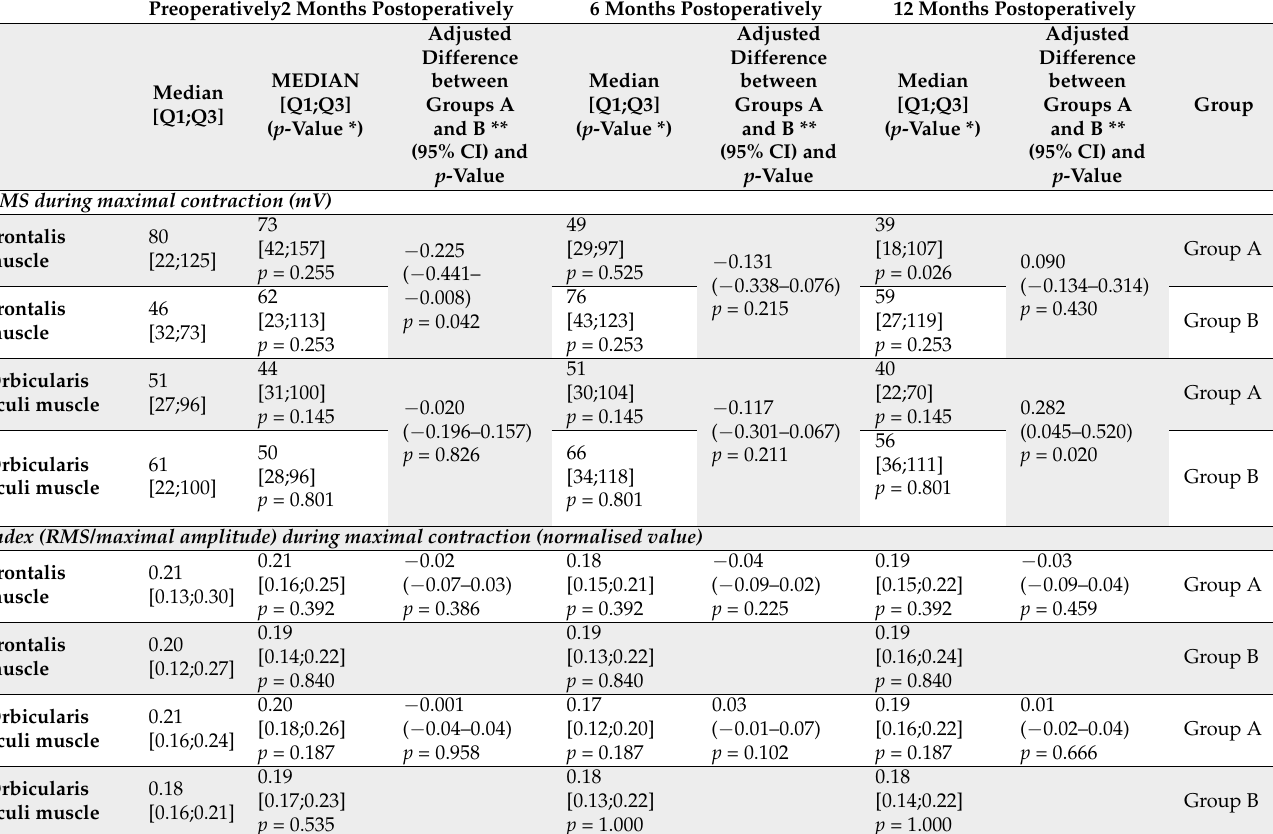
Table 5. Pre-and post-operative EMG values (median[Q1;Q3]) and differences between